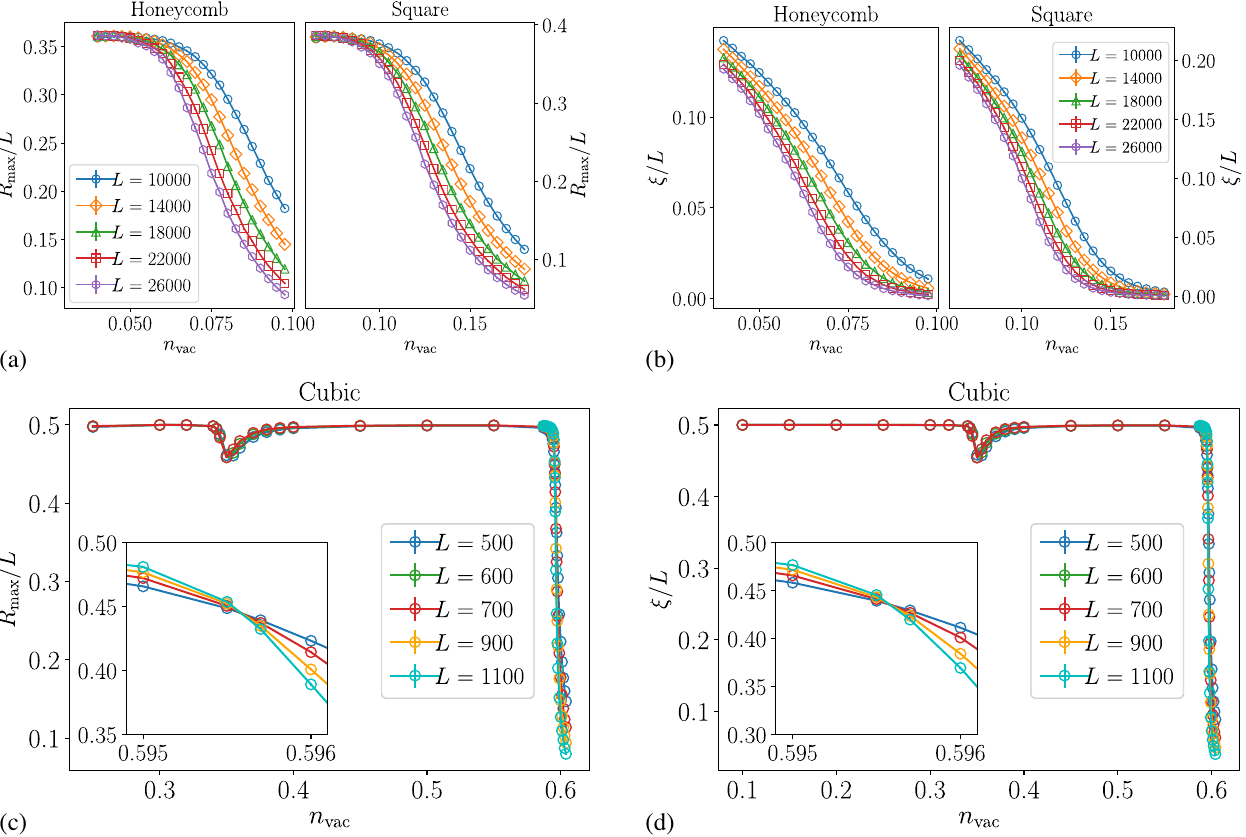
FIG. 7. R , the sample-averaged radius of gyration of the largest R -type region in a sample, and the correlation length ξ (associated max with the sample-averaged geometric correlation function) both increase rapidly in the small- n limit to values that are set by the system vac =L and ξ =L size L for accessible system sizes in two and three dimensions. In two dimensions, curves of the dimensionless ratios R max corresponding to different L do not cross over the range of n accessible to our numerics. However, on the cubic lattice, there is a clear vac ≈ 0 . 6 [insets of (c) and (d)]. See Sec. VI for crossing in the vicinity of n vac